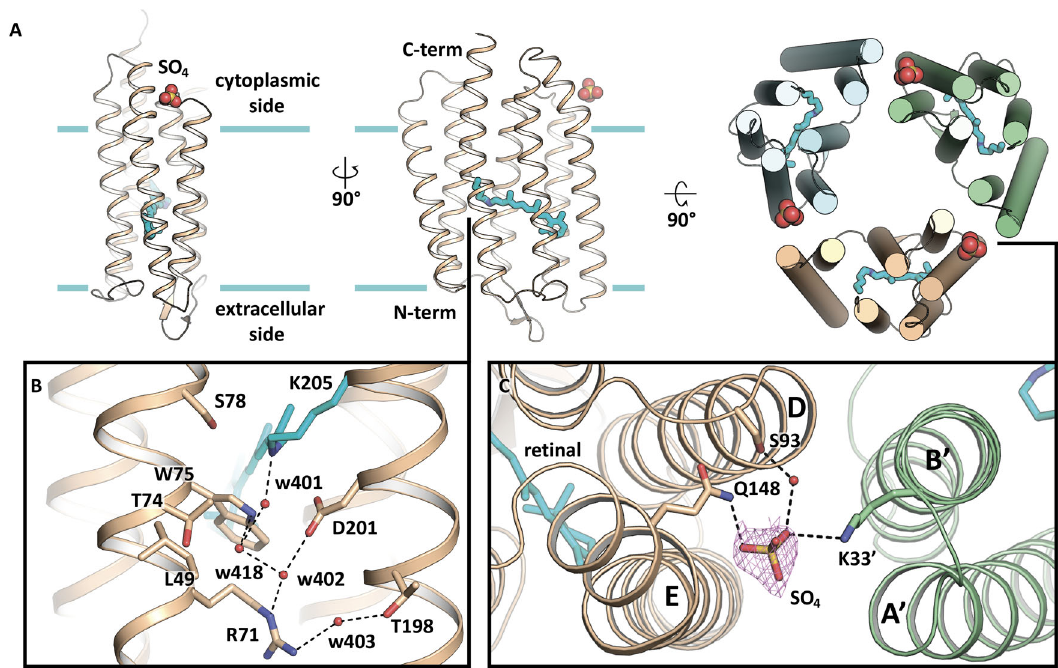
Fig. 3 | Structure of SO 4 2- -bound form of Sy HR v . A Overall view of the Sy HR v protomer in the membrane. Calculated hydrophobic-hydrophilic membrane boundaries are shown as blue lines. Sulfate ion is shown with spheres. The right section represents the view of the Sy HR v trimer from the cytoplasmic side. B